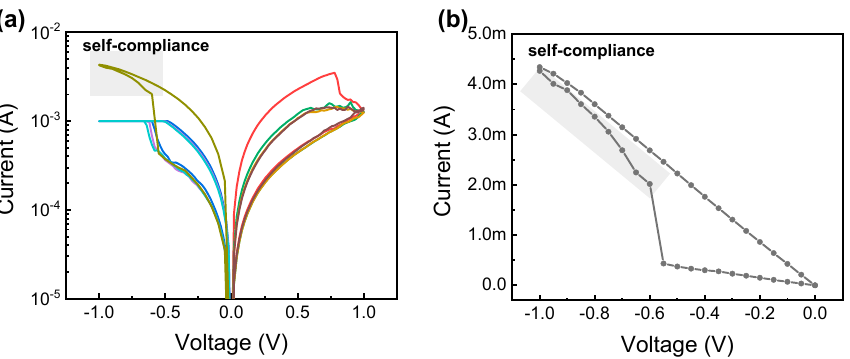
Figure 4. Self-compliance characteristics of the Pt/TiO 2 /HfAlO x /TiN RRAM device: ( a ) log-scale; ( b ) linear scale.